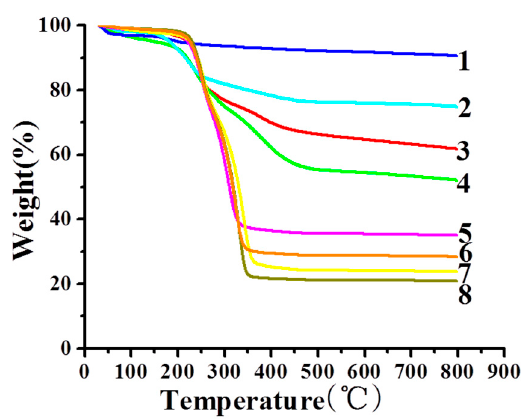
Figure 3. TGA of sample when (1) cyclohexane replacing L-proline, (2) pyrrolidine replacing L-proline, (3) glycine replacing L-proline, (4) arginine replacing L-proline, (5) L-proline replacing glycine, (6) L-proline replacing pyrrolidine, (7) L-proline replacing arginine, and (8) L-proline replacing cyclohexane. The weight loss of L-proline was measured in its decomposition range of 229–347 ° C.